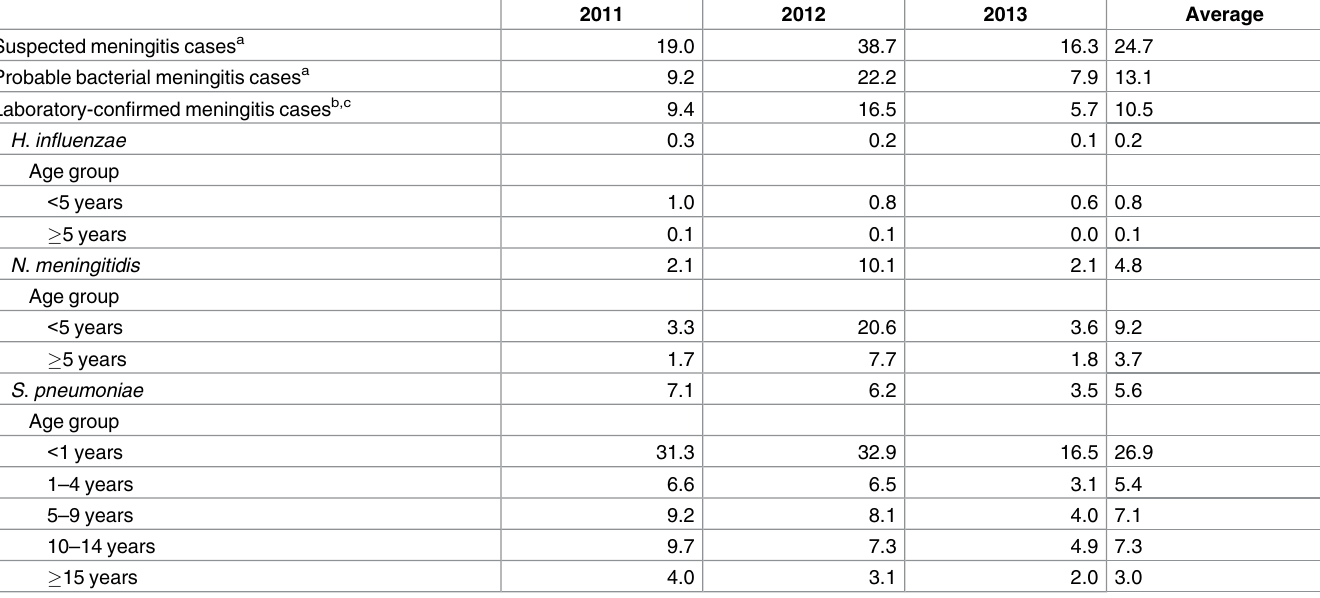
Table 3. Annual incidence (casesper 100,000persons) of suspected, probable, and confirmed meningitis, Burkina Faso,